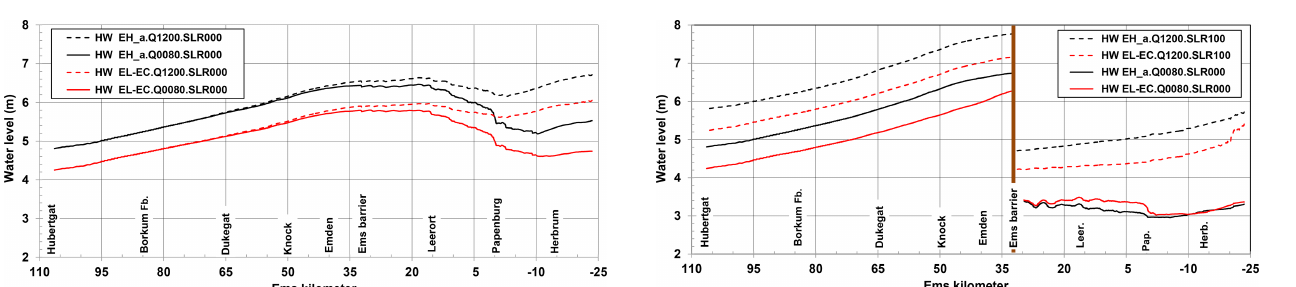
Figure 11. Highest water levels along a longitudinal profile in the Ems estuary for an operated storm surge barrier without further am- plification ( Q = 80m 3 s − 1 , SLR = 0cm; solid lines) and a simula- tion with amplified conditions ( Q = 1200m 3 s − 1 , SLR = 100cm; dashed lines) for EH_a (black lines) and EL (red